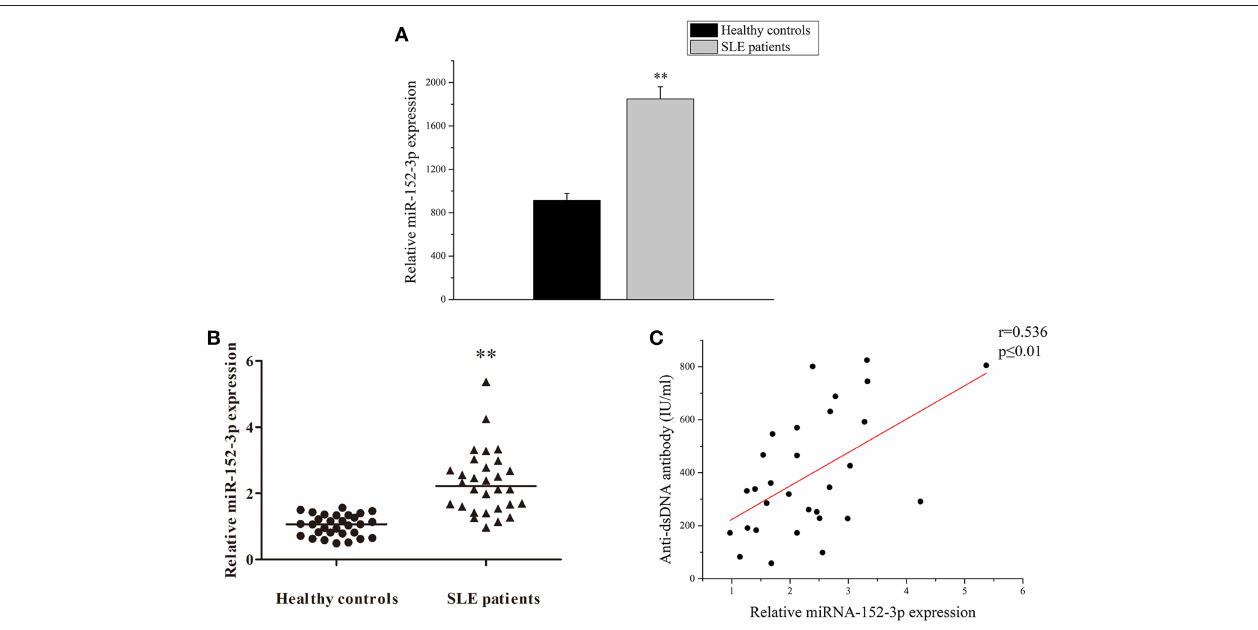
FIGURE 1 | Increased miR-152-3p expression in SLE B-cells. (A) The differences in the expression of miRNA-152-3p between SLE and control samples. The variables were compared using the Student t -test. (B) Relative miRNA-152-3p expression level in B-cells isolated from healthy controls or patients with SLE ( n = 30 for each group) was assessed by real-time PCR and normalized to RNU6-2. The variables were compared using the Mann-Whitney U -test. (C) The correlation between miR-152-3p expression and anti-dsDNA antibody level in SLE B-cells ( n = 30). ** P <